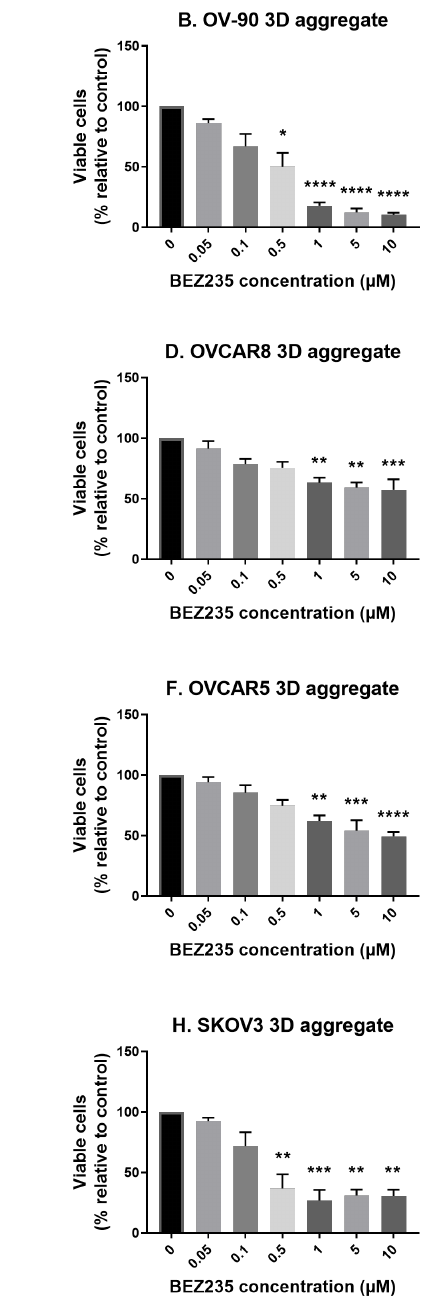
Figure 1. The effect of the dual phosphoinositide 3-kinase (PI3K) and mechanistic target of rapamycin (mTOR) inhibitor BEZ235 on cell viability in OV-90 ( A , B ), OVCAR8 ( C , D ), OVCAR5 ( E , F ) and SKOV3 ( G , H ) monolayer and aggregate cultures. Cell viability was significantly reduced, relative to the control, at concentrations of 0.05 (OV90, OVCAR8, OVCAR5 and SKOV3 monolayers), 0.5 (OV90 and SKOV3 aggregates) and 1 µ M (OVCAR8 and OVCAR5 aggregates) and above. Cultures were established for 48 h prior to a 72 h exposure to BEZ235 at the concentrations shown. Cell viability was determined by staining cells with trypan blue and conducting a cell count. Data are expressed as mean ± SEM (n = 4). Statistical significance is at p < 0.05 and is in comparison to the control. The statistically significant differences are indicated as p < 0.05 (*), p < 0.01 (**), p < 0.001 (***) and p < 0.0001 (****), as determined by one-way ANOVA with a Dunnett’s multiple comparison test on log transformed